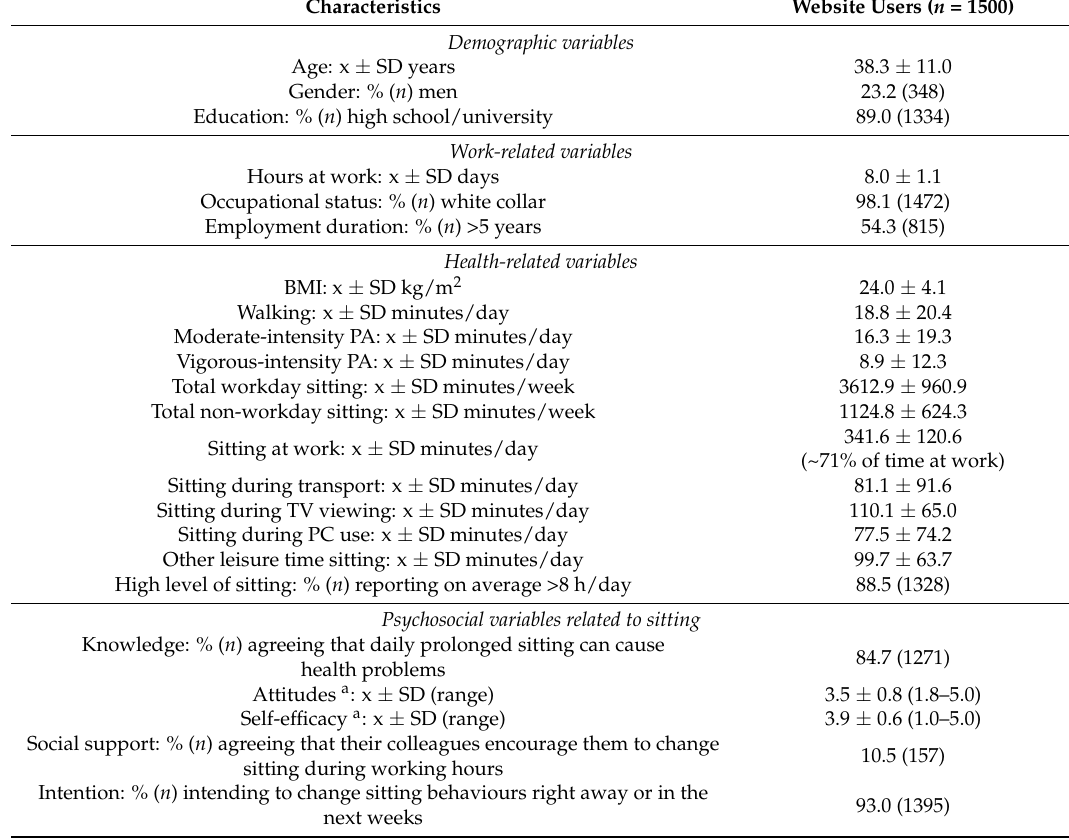
Table 2. Characteristics of the website users completing the assessment